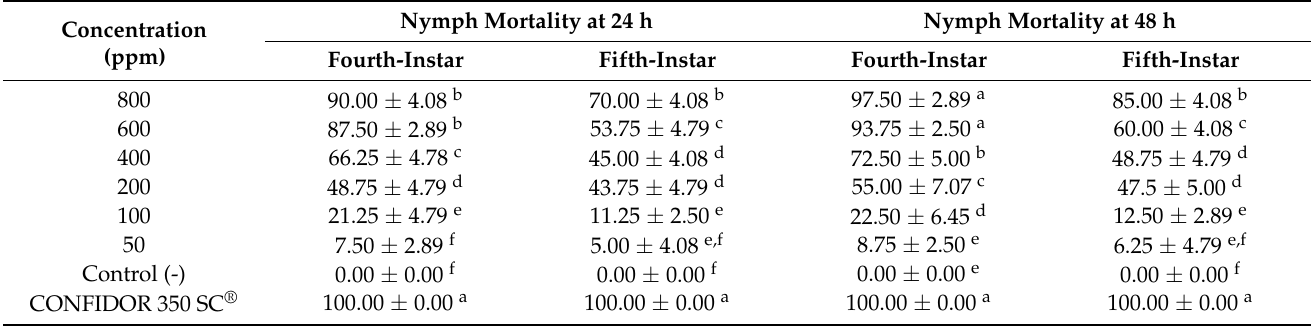
Table 2. Mortality (%) of Bactericera cockerelli nymphal stages treated with Schinus molle essential oil.